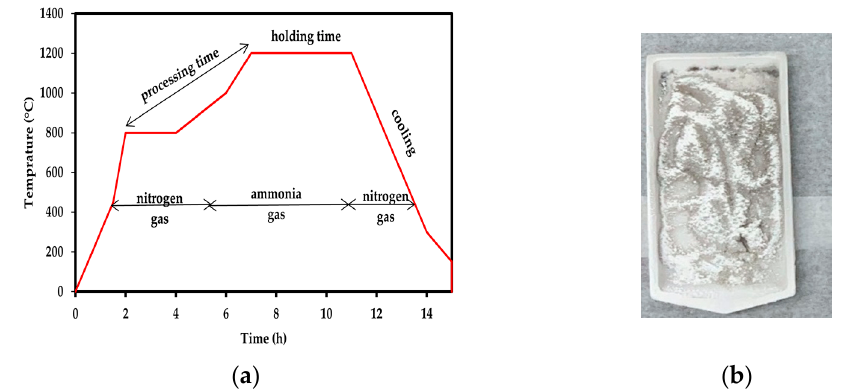
Figure 1. ( a ) Temperature setting for synthesis BNNTs under N 2 and NH 3 gas; ( b ) as-synthesised BNNTs (r-BNNTs) powder.